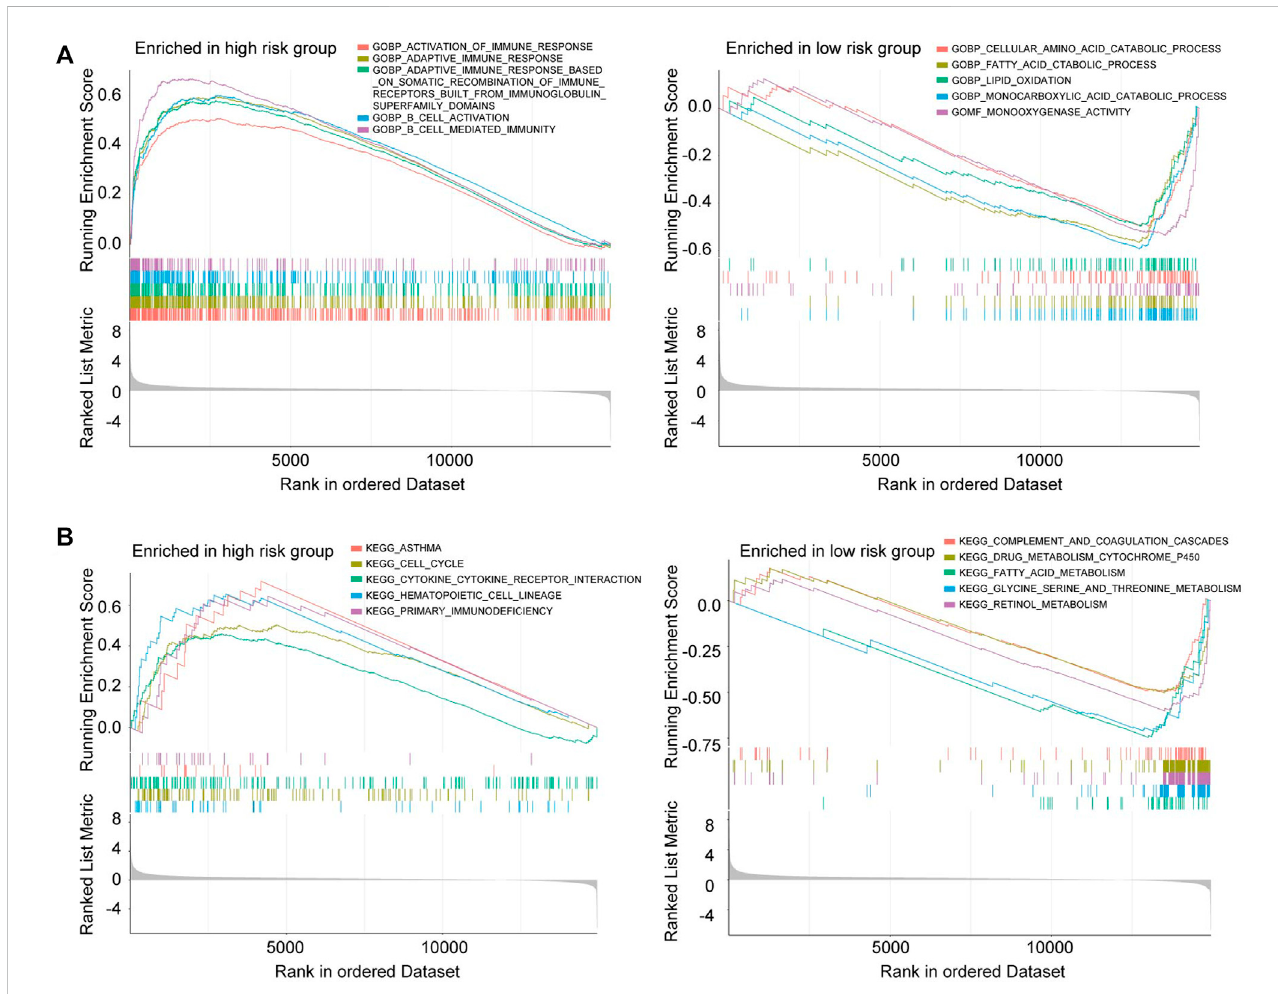
FIGURE 13 Gene Set Enrichment Analysis (GSEA) in the high-risk group and low-risk group. (A) GO enrichment analysis of high-risk group (left) and low-risk group (right). (B) KEGG enrichment analysis of high-risk group (left) and low-risk group